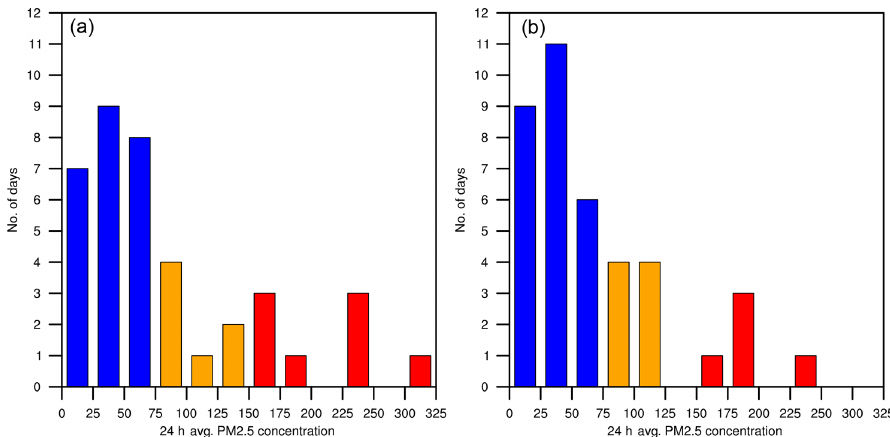
Figure 10. Frequency distribution of daily average PM 2 . 5 over 12 October–19 November 2014, showing the number of days meeting thresholds of 75µgm − 3 (blue) and 150µgm − 3 (blue plus orange) without (a) and with (b ) emission controls.